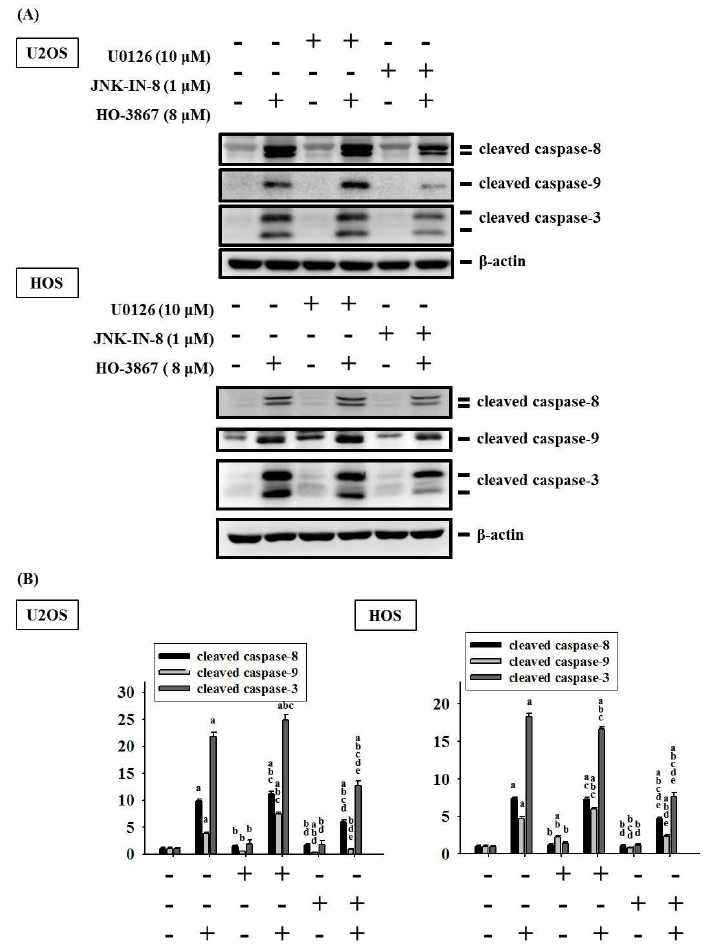
Figure 7. Analysis of HO-3867 on cleaved caspases 8, 9 and 3 expressions in HO-3867 with or without inhibitors of ERK1/2 (U0126)- and JNK1/2 (JNK-IN-8)-treated U2OS and HOS cells. ( A ) After pretreatment with or without 10 µ M of U0126 and 1 µ M of JNK-IN-8 for 1 h followed by 8 µ M or no HO-3867 treatment for an additional 24 h, Western blot analysis was performed to measure expressions of cleaved caspases 3, 8, and 9 in U2OS and HOS cells; ( B ) Subsequently, quantitative analysis was assessed. n = 3. Cleaved caspase 8: U2OS: F = 536.028, p < 0.001; HOS: F = 719.244, p < 0.001; cleaved caspase 9: F = 550.879, p < 0.001; HOS: F = 436.343, p < 0.001; cleaved caspase 3: U2OS: F = 693.877, p < 0.001; HOS: F = 2338.671, p < 0.001. a Significantly different, p < 0.05, when compared to control. b Significantly different, p < 0.05, when compared to 8 µ M HO-3867. c Significantly different, p < 0.05, when compared to U0126. d Significantly different, p < 0.05, when compared to U0126 and HO-3867 treatment. e Significantly different, p < 0.05, when compared to